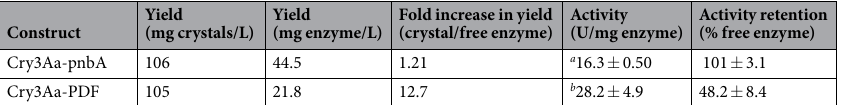
Table 2. Yield and specific activity of other Cry3Aa-fusion constructs. a For pnbA,1 unit is the amount of enzyme required to produce 1 μ mol pNP per min at 25 °C. b For PDF, 1 unit is the amount of enzyme required to produce 1 μ mol formate per h at 25 °C. Activity measurements were performed in triplicate, and the averages are shown with the standard deviation of the